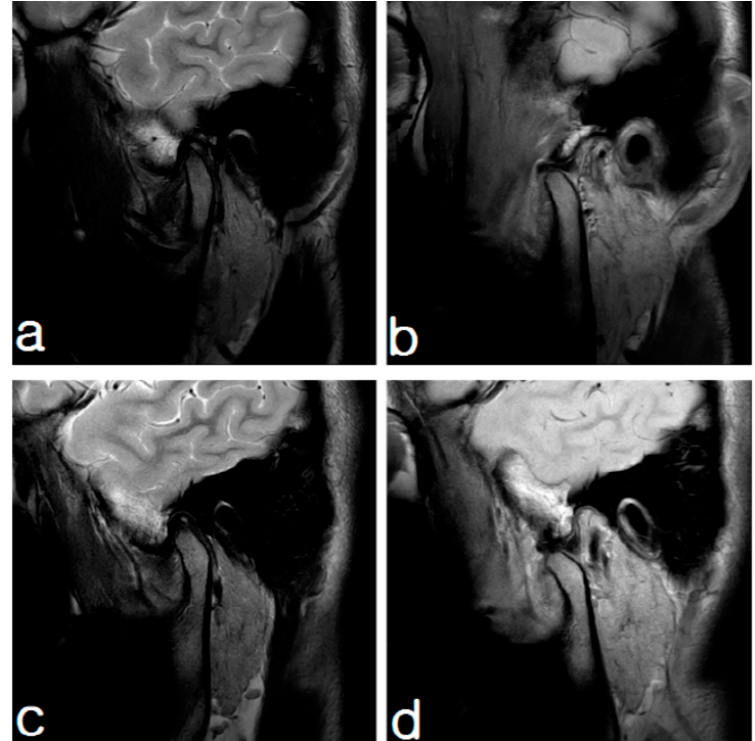
Figure 2. Temporomandibular joint magnetic resonance imaging (proton density, sagittal view). The positions of both articular discs were normal at both closed and open mouth positions. ( a ): left, closed; ( b ): left, open; ( c ): right, closed; and ( d ): right, open.